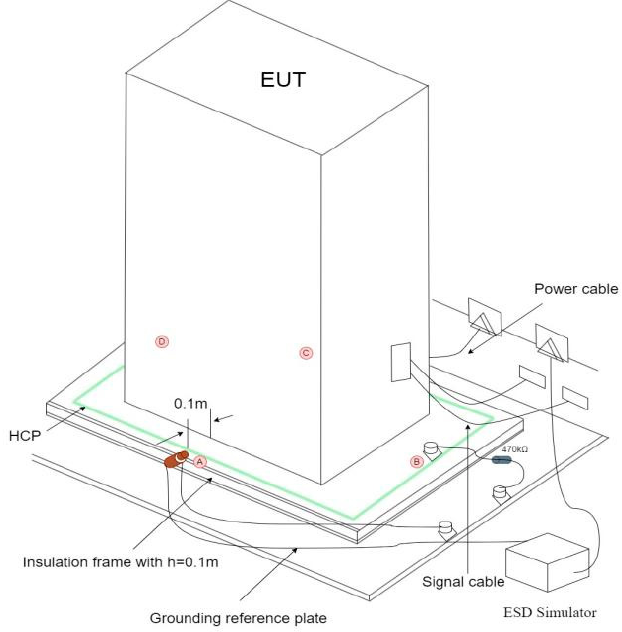
Figure 9. Testing points for horizontal coupling plate discharge.